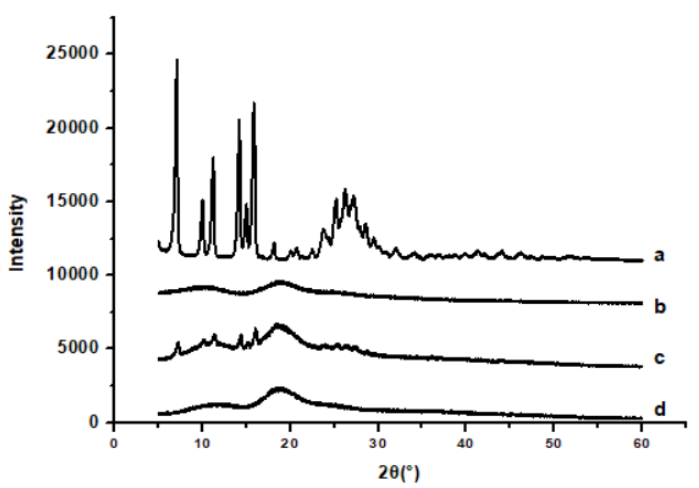
Figure 6. XRD results of samples. (a) Raw API, (b) API nanoparticles, (c) API and HP- β -CD mixture, and (d) HP- β -CD.